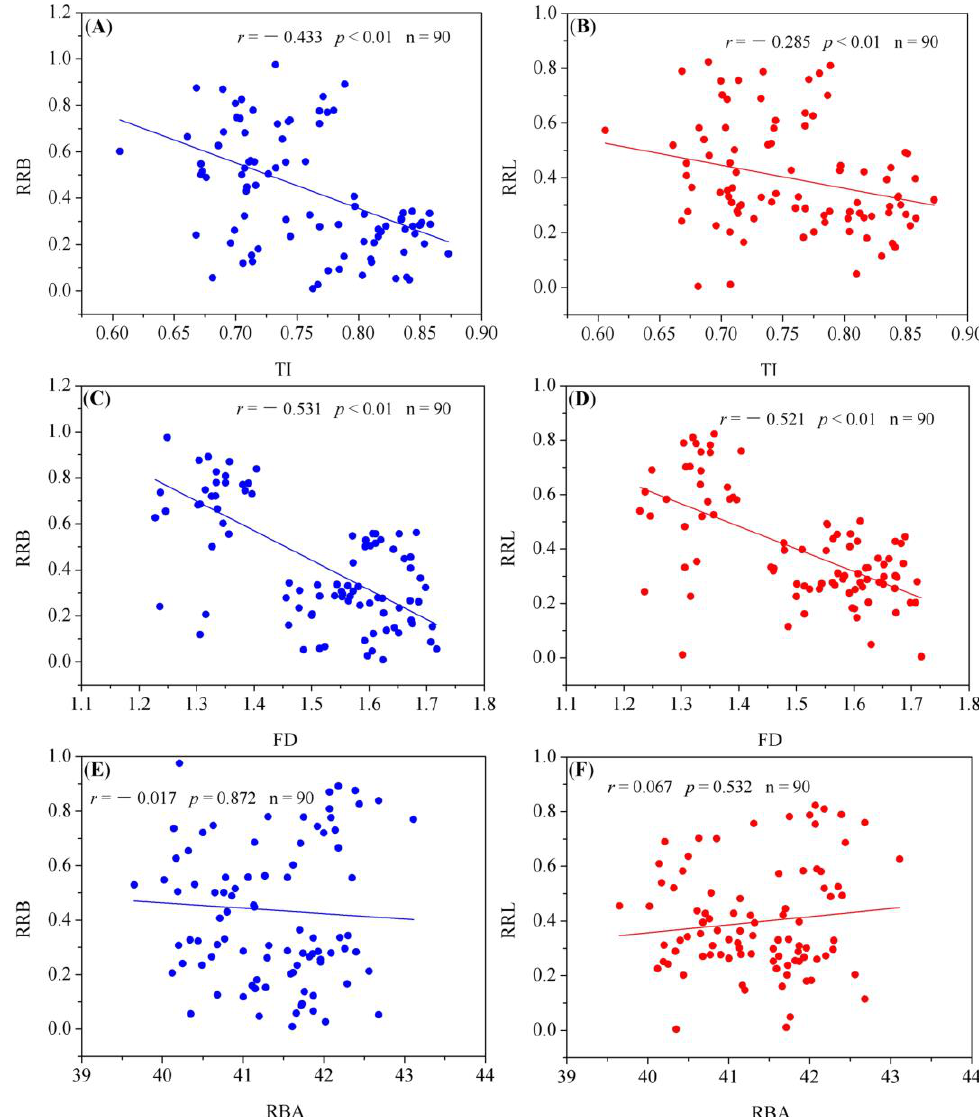
Figure 6. Relationships between RR and root architecture parameters (TI, RBA, FD). r: correlation coefficient, n: total number of samples. The relationship between RRB and root architecture parameters (( A ): TI, ( C ): FD, ( E ): RBA) is represented by three blue scatter diagrams, while the relationship between RRL and root architecture parameters (( B ): TI, ( D ): FD, ( F ): RBA) is represented by three red scatter diagrams.